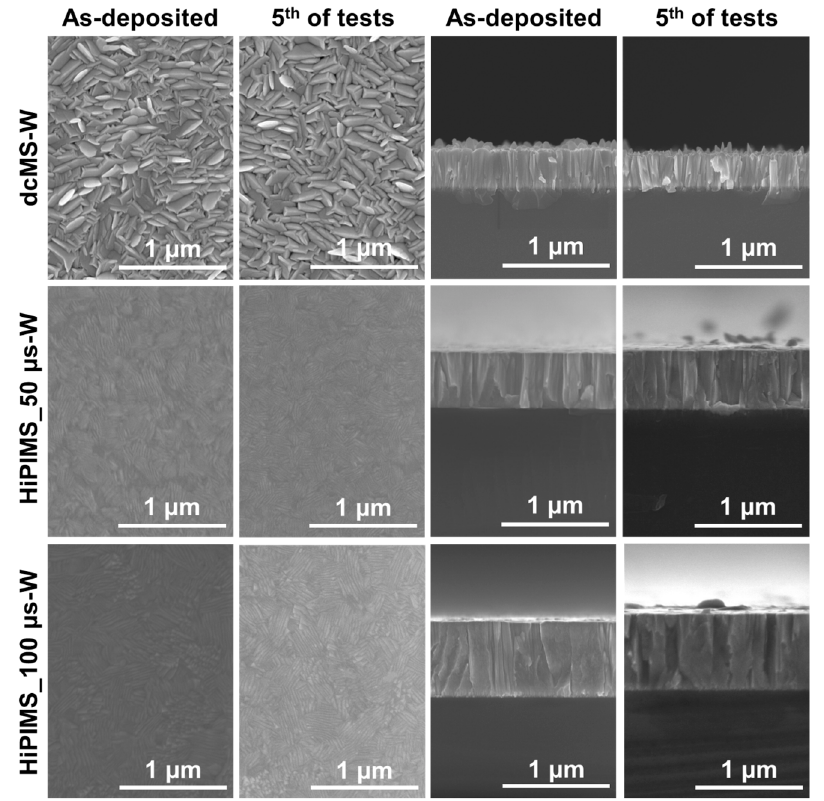
Figure 6. Surface and cross-section SEM images of W thin films prepared by dcMS and HiPIMS after cycle thermal resistance measurements.